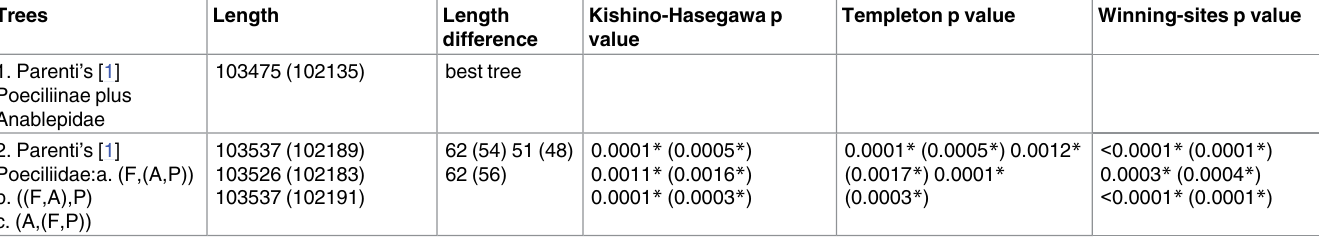
Table 2. Summaryof statistical tests regarding the sister group to Poeciliinae.